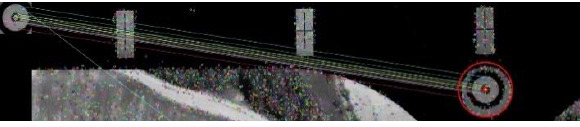
Figure 4. Automatic identification of FM, comparison with FM library and its